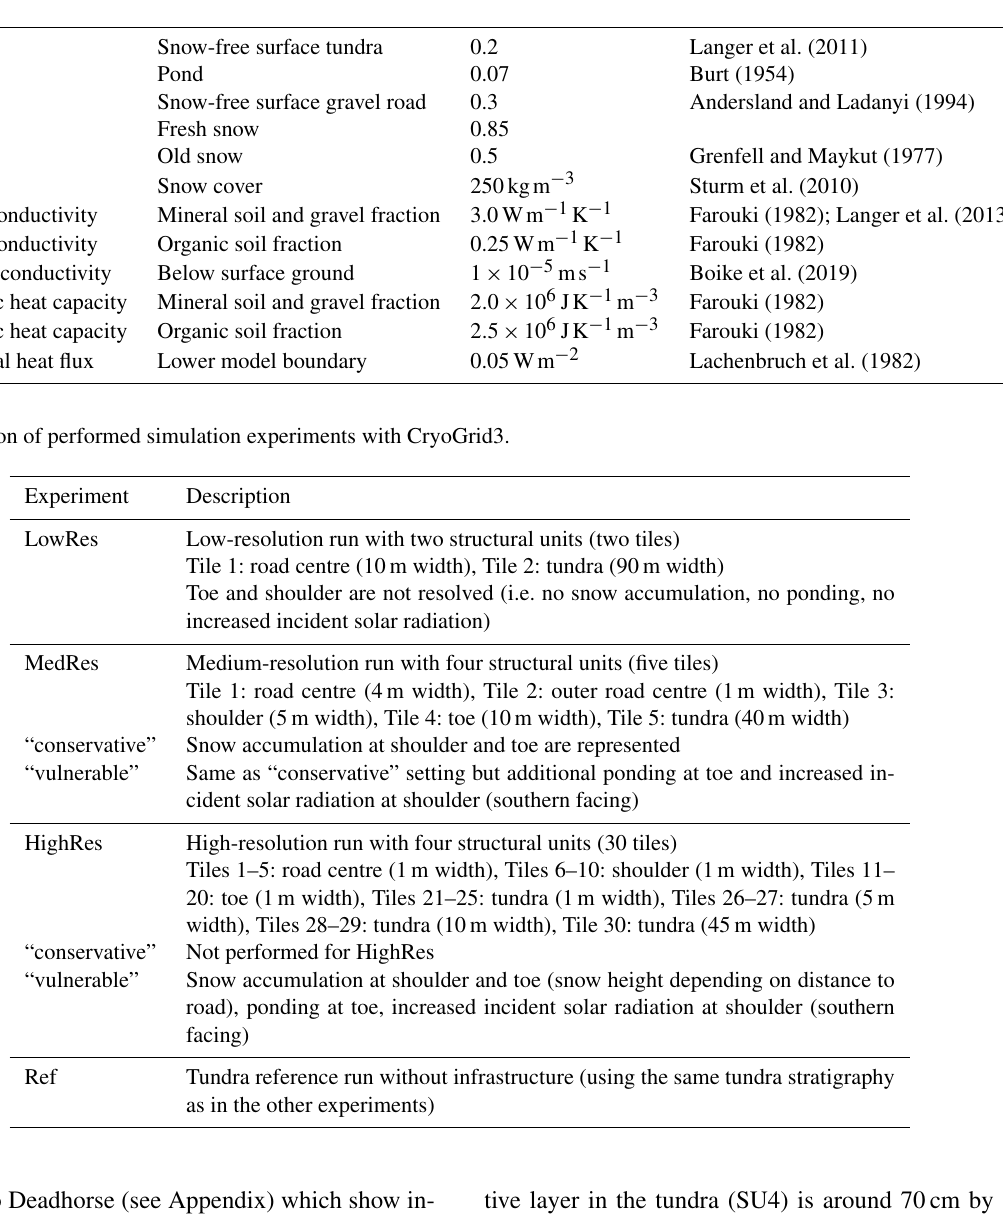
Table 2. Model parameters in CryoGrid3 used in this study. Effective thermal conductivities and heat capacities of each model layer are calculated based on the volumetric fractions of the ground constituents of water, ice, air, mineral, gravel, and organic (Cosenza et al., 2003; Westermann et al., 2013). The temperature dependence of the effective thermal conductivity and capacity is taken into account by calculating temperature-dependent water and ice contents.